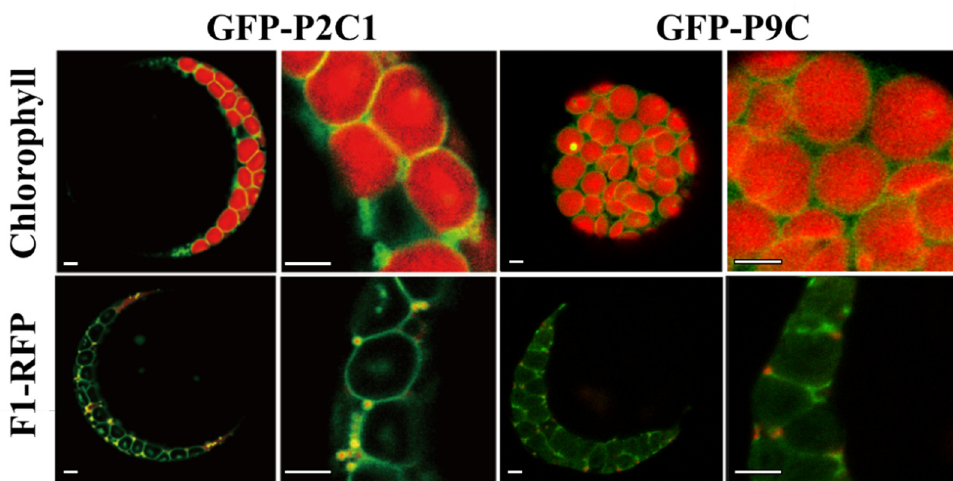
Figure 1. Targeting of GFP to organelles in Arabidopsis protoplasts by the C-terminal motifs of AtPAP2 and AtPAP9. GFP-P2C1 was targeted to the outer membranes of chloroplasts and mitochondria, and GFP-P9C was targeted to the outer membrane of only chloroplasts. Chlorophyll was the chloroplast marker, and F1-RFP was the mitochondrion marker. Scale bar = 5 μ m.